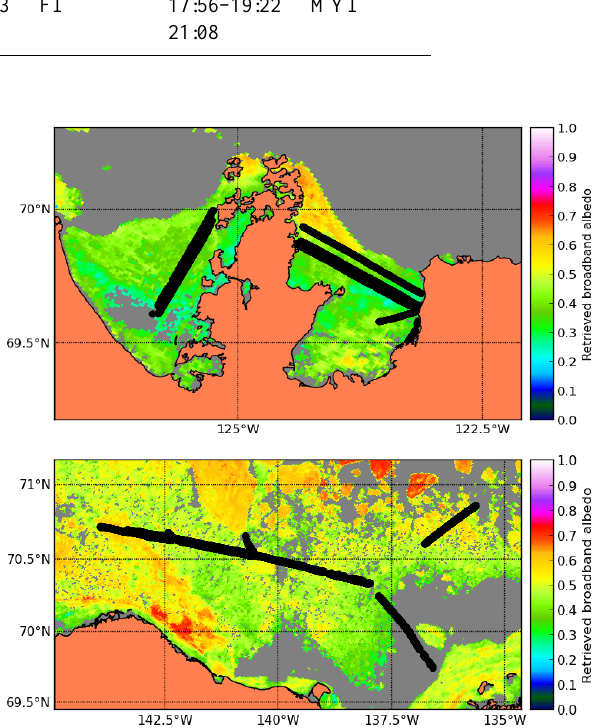
Figure 4. Examples of ice conditions present during MELTEX 2008 flights over landfast ice on 6 June 2008 (top panel) and over sepa- rate ice floes of various sizes on 4 June 2008 (bottom panel). The black tracks depict the flight tracks with albedo measurements. The colour code illustrates the satellite retrieved broadband albedo. The background consists of the coral filled land mask and grey filled data gaps due to cloud contamination or surface type other than sea